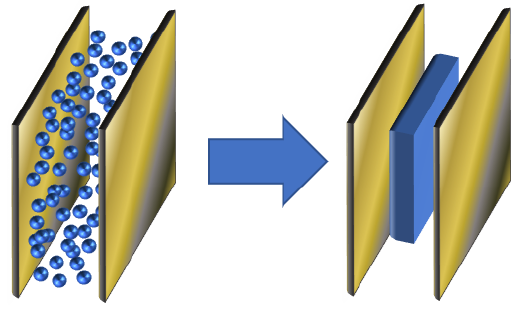
Figure 1. Plane capacitor with equivalent metal cuboid placed inside